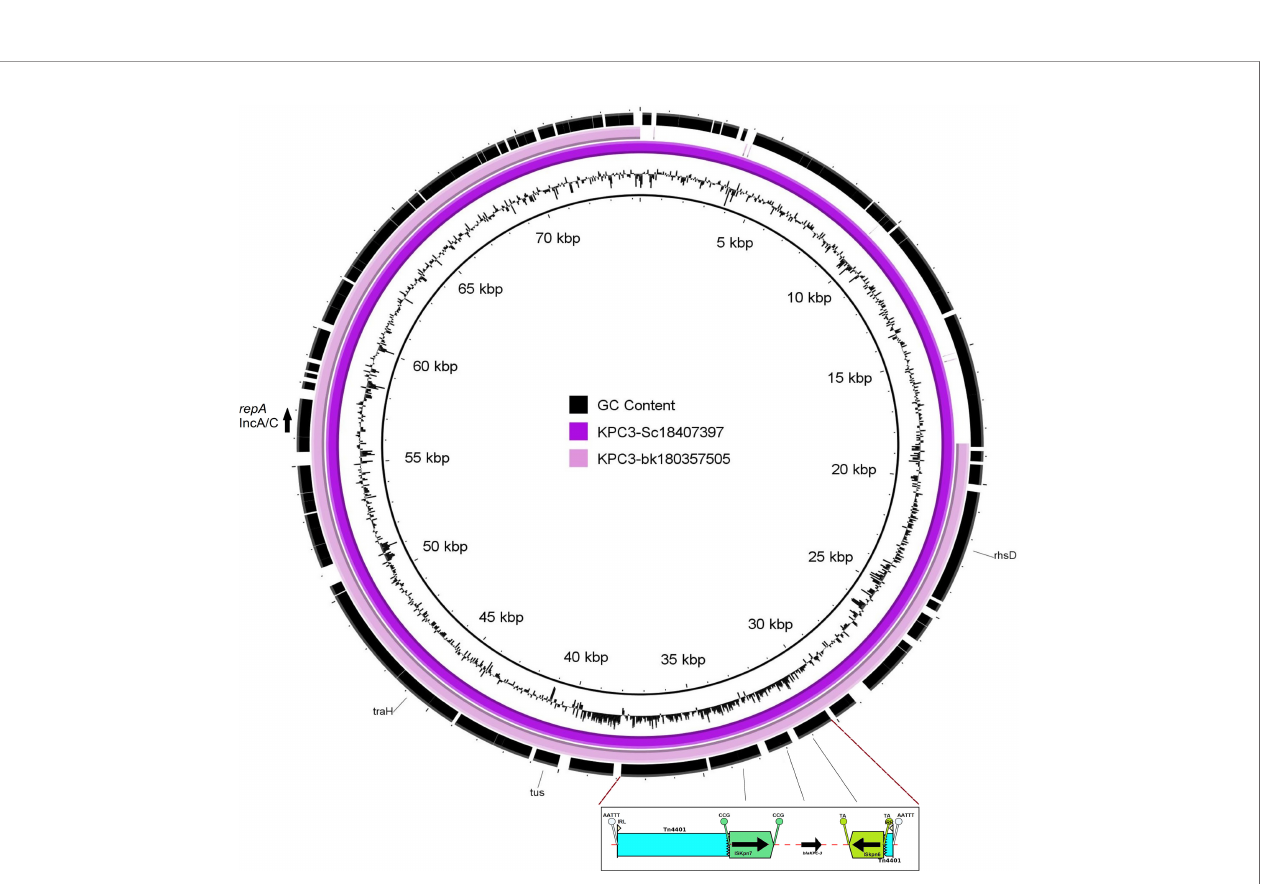
FIGURE 3 | Genetic Map of IncA/C2 plasmid encoding a Tn 4401 associated bla KPC-3 - carbapenemase.